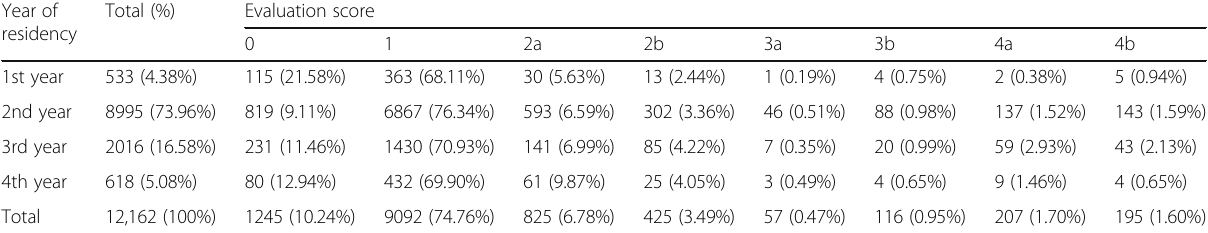
Table 4 Distribution by year of residency with evaluation score detail Year of residency